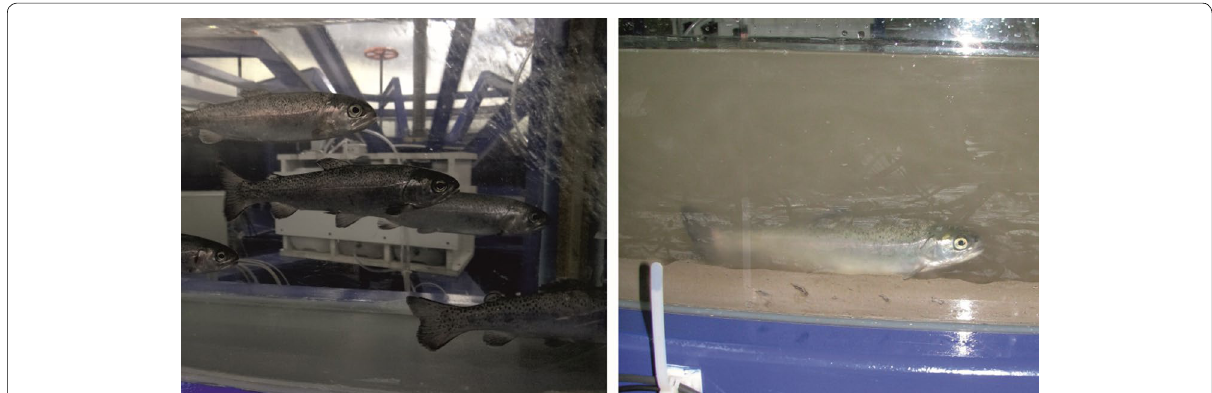
Fig. 3 Hydro‑toxic studies on sediment‑bound pollutants in the circular flume at IWW. Rainbow trouts ( Oncorhynchus mykiss ) were exposed to clear water (negative control, left) and water–sediment‑mixtures (right) that were artificially spiked with environmental pollutants, e.g., polycyclic aromatic hydrocarbons